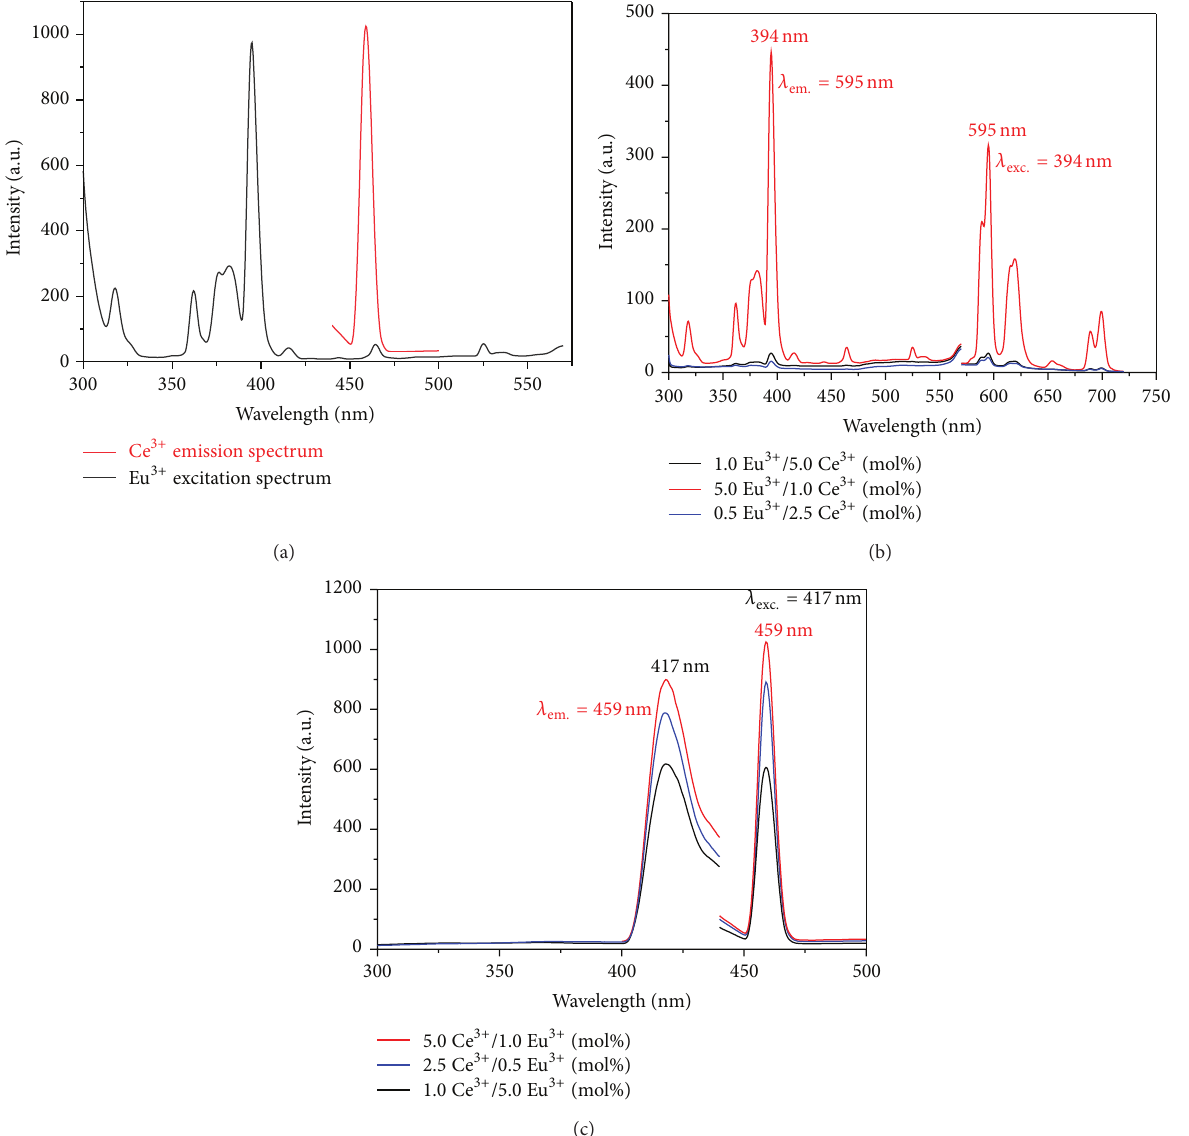
Figure 7: (a) Comparison of Eu 3+ : excitation spectrum and Ce 3+ : emission spectrum, (b) and (c) PLE and PL spectra of all the Ce 3+ /Eu 3+